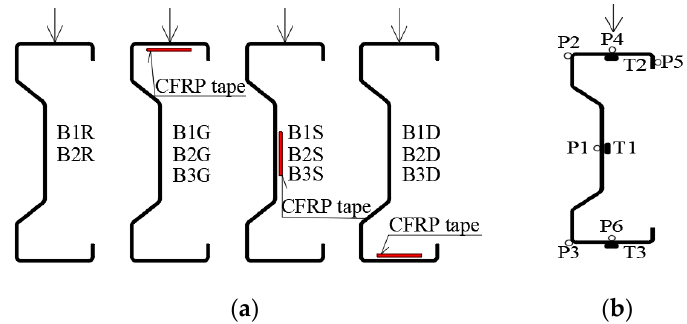
Figure 5. Scope of the tests: ( a ) steel tapes location and sample symbols; ( b ) measuring points in the